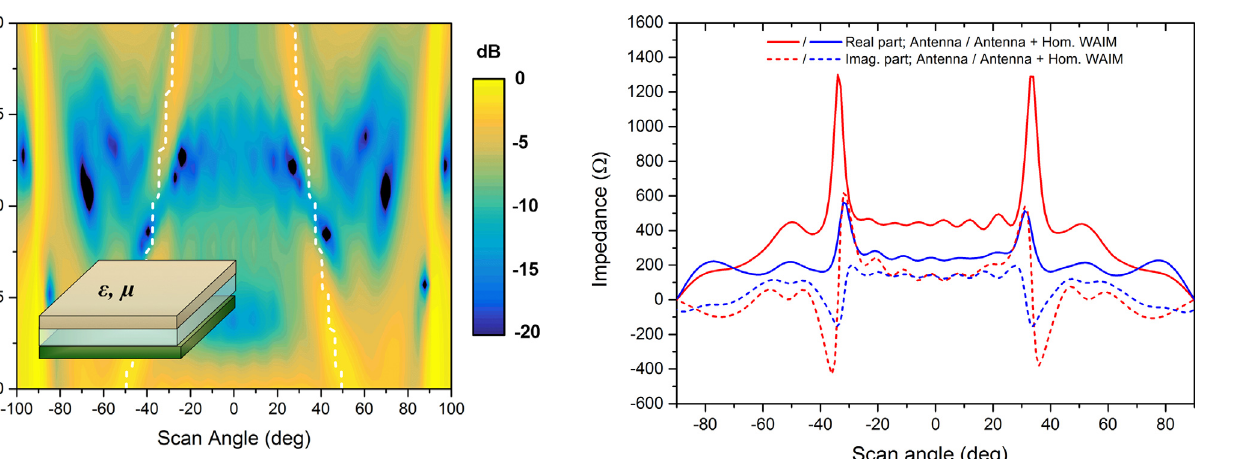
Figure 8. E-plane scan impedance for the 50th element versus angle of incidence for the infinitely replicated prototype antenna without (solid line) and with an homogenous anisotropic WAIM on top (dashed line). Red color stands for the real part while blue color line corresponds to the imaginary part.